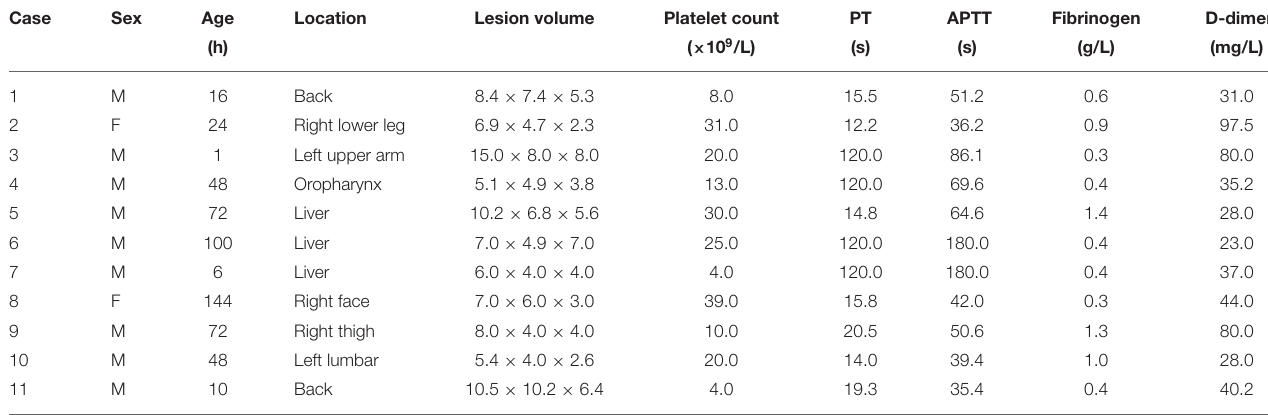
TABLE 1 | Clinical characteristics upon admission.